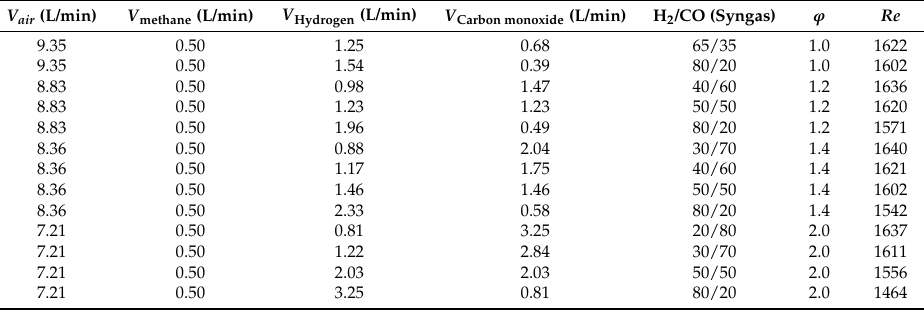
Figure 3. Typical flame patterns of the CH 4 /syngas/air premixed impinging flame.